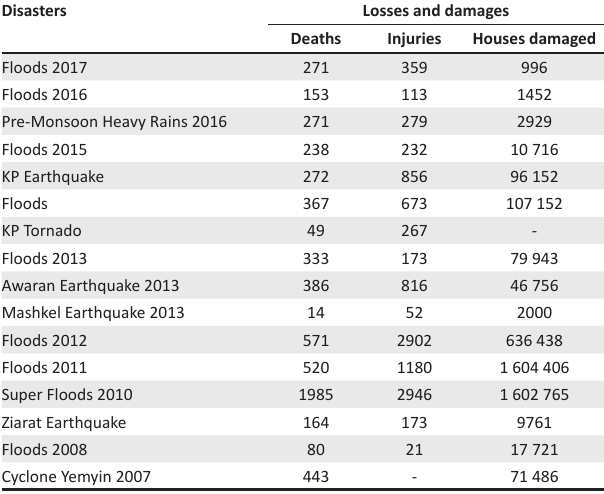
TABLE 1 : Summary of damages and losses in years